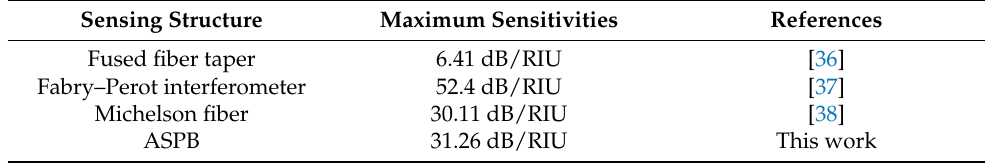
Table 4. Comparison of the ASPB with the reported sensors with different